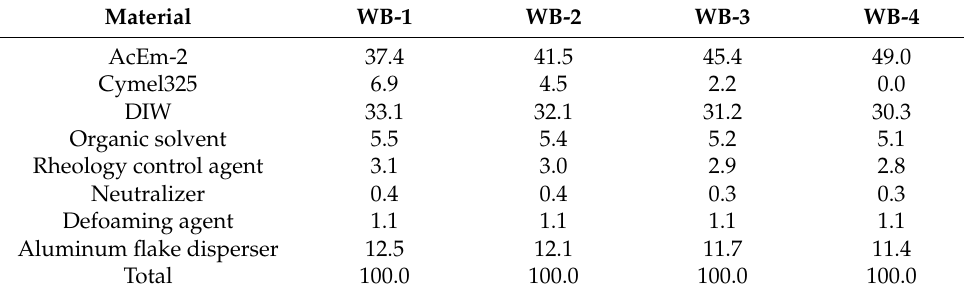
Table 3. Formulation of waterborne basecoats (wt.%).